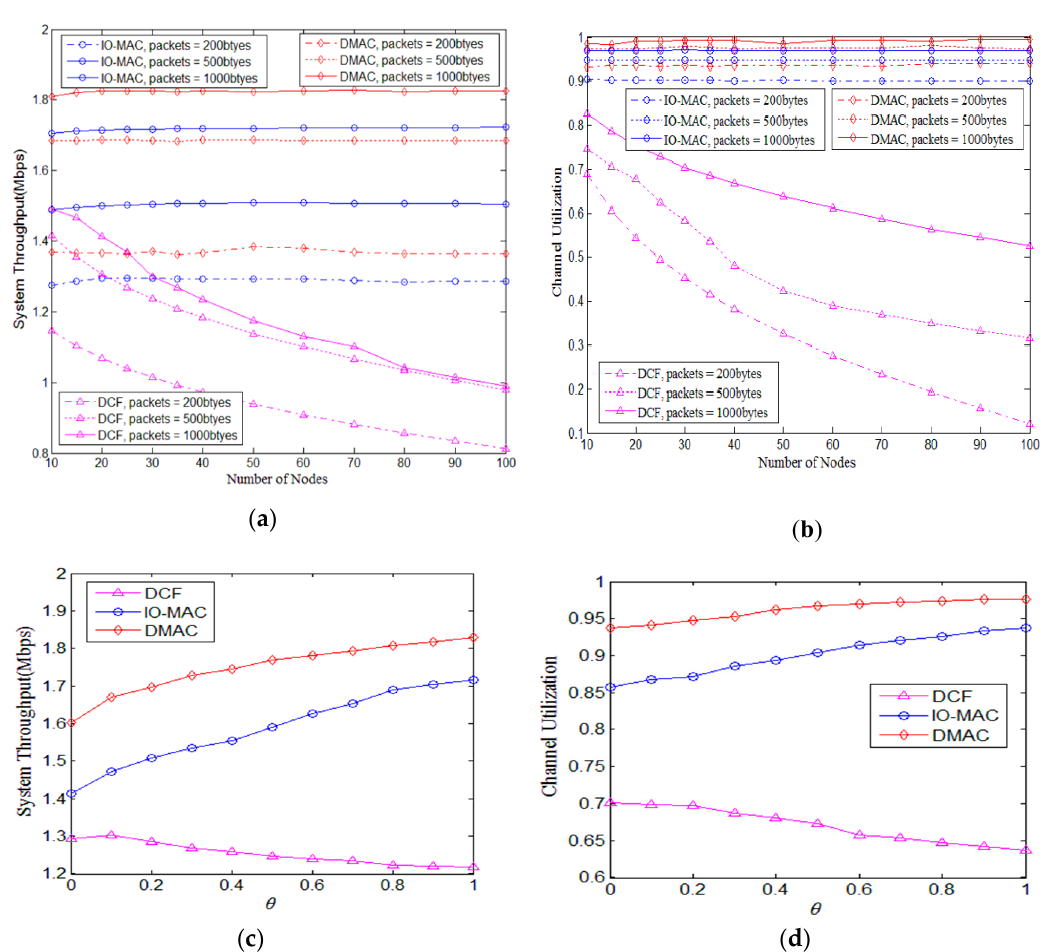
Figure 4. Throughput and utilization in saturated and non-saturated scenarios. ( a ) System Throughput in saturated scenario; ( b ) Channel utilization in saturated scenario; ( c ) System Throughput in non-saturated scenario; and, ( d ) Channel utilization in non-saturated scenario.